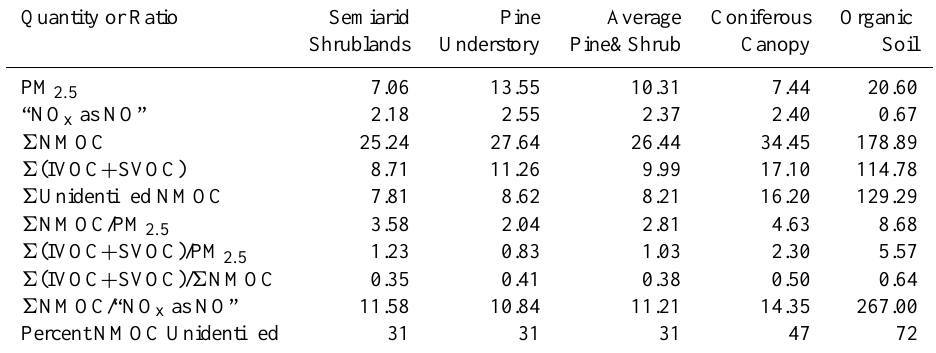
Table 3. Calculation of some lumped categories in gkg − 1 and indicated mass ratios or percentages (see text for category definitions). Quantity or Ratio Semiarid Pine Average Coniferous Organic Shrublands Understory